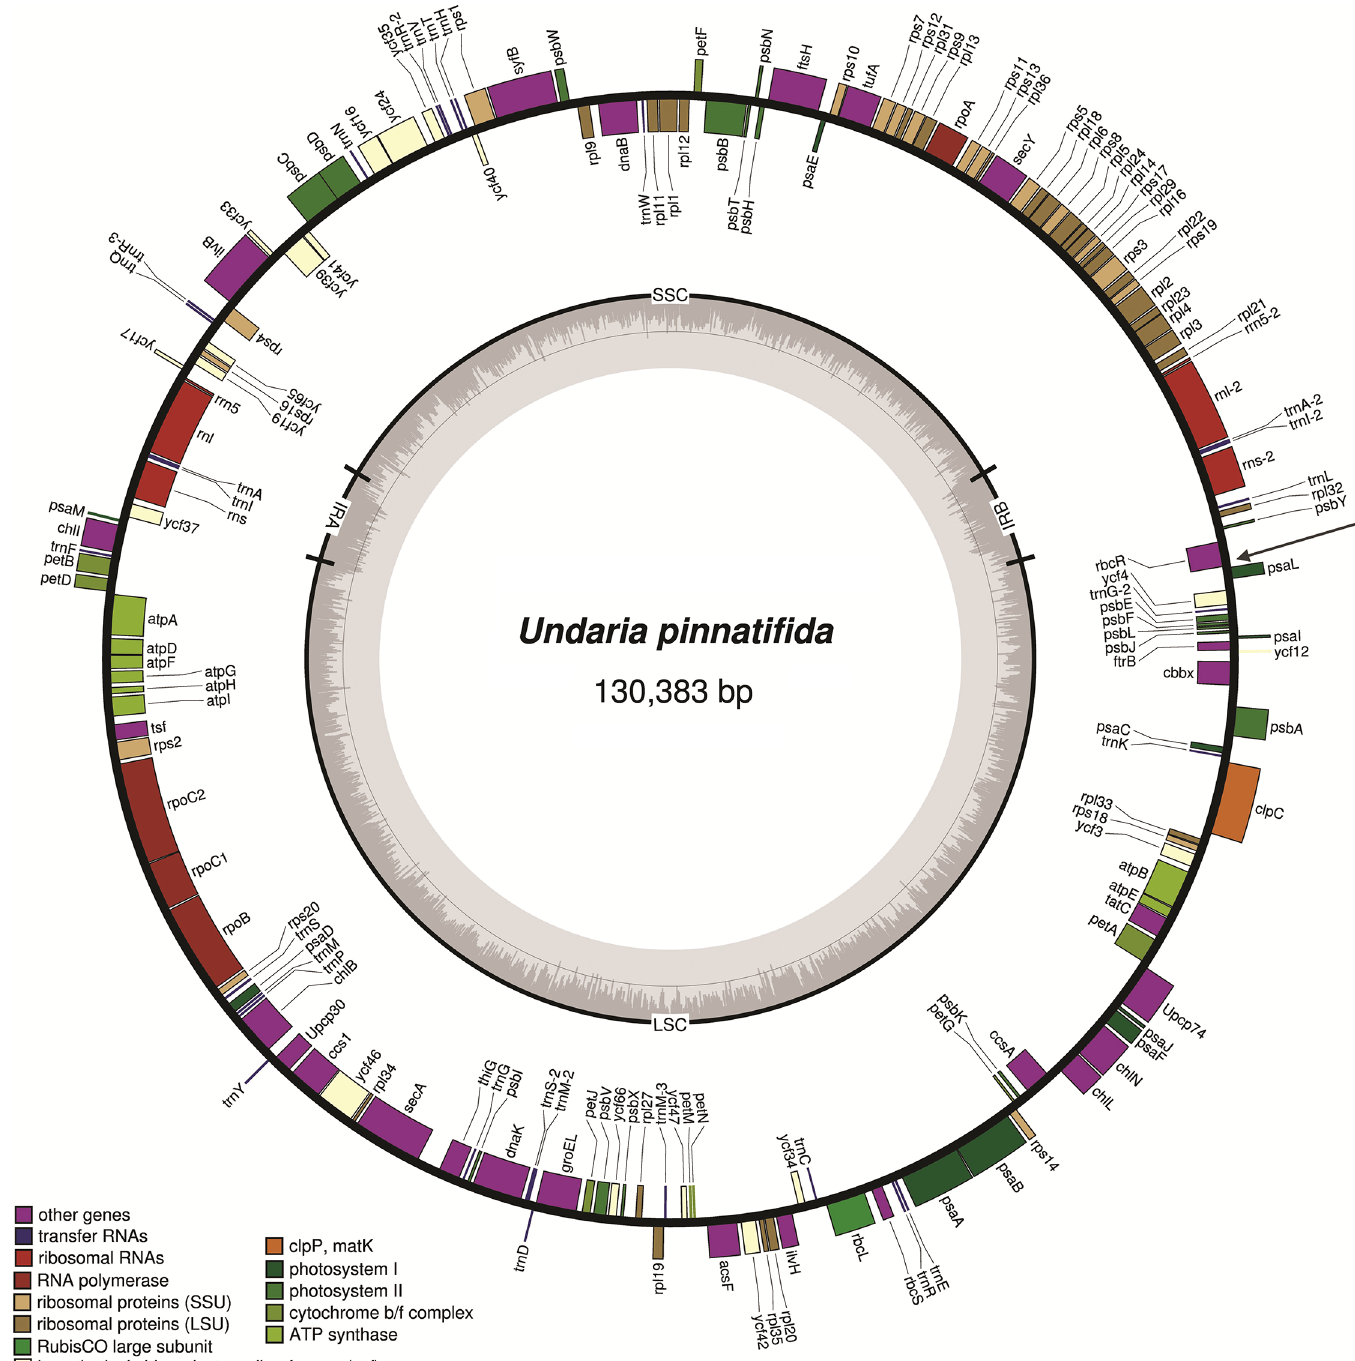
Fig 1. Gene map of the Undaria pinnatifida plastid genome. Genes on the outside of the map are transcribed counterclockwise and those on the inside of the map are transcribed clockwise. The innermost gray ring represents the GC content. The black arrow indicates the position of the stem-loop structure. doi:10.1371/journal.pone.0139366.g001 Four gene overlaps were identified: rpl23 overlapped with rpl4 by 8 nt, ftrB overlapped with